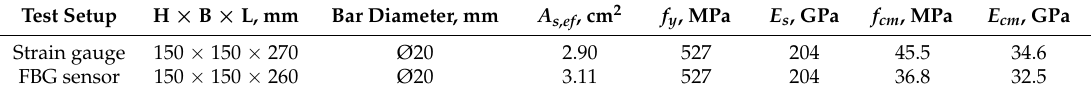
Table 1. Specimen material and geometrical properties.